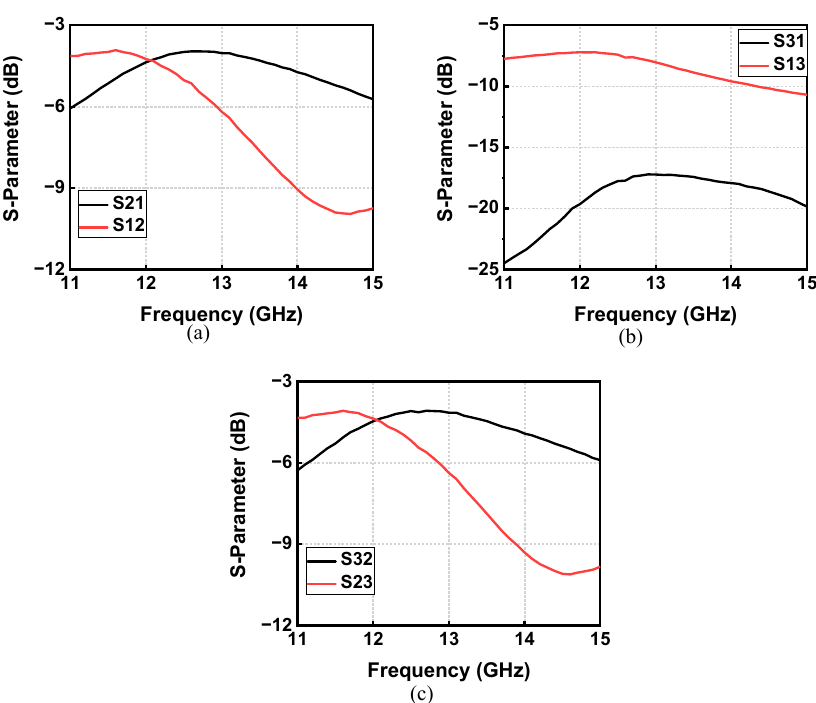
width of 1-dB IL degradation is 2.7 GHz (21.4%), corresponding to an isolation of 17.2 to 21.7 dB.